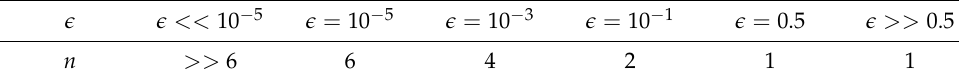
Table 5. Applying the FPA to find n for various (cid:101) and x = 0.8.